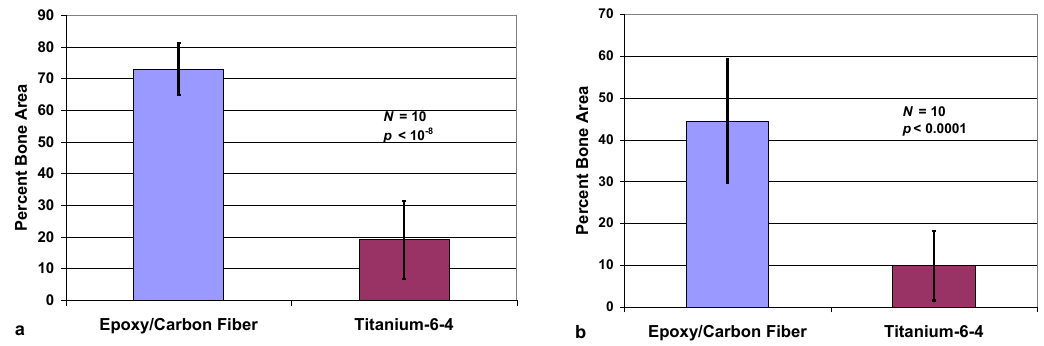
Figure 2. Implant percent bone areas comparing epoxy/carbon fiber PMC to Ti-6Al-4V alloy ( a ) Distance 0.1 mm from implant ( b ) Distance 0.8 mm from implant. (error bars ±1 standard deviation).